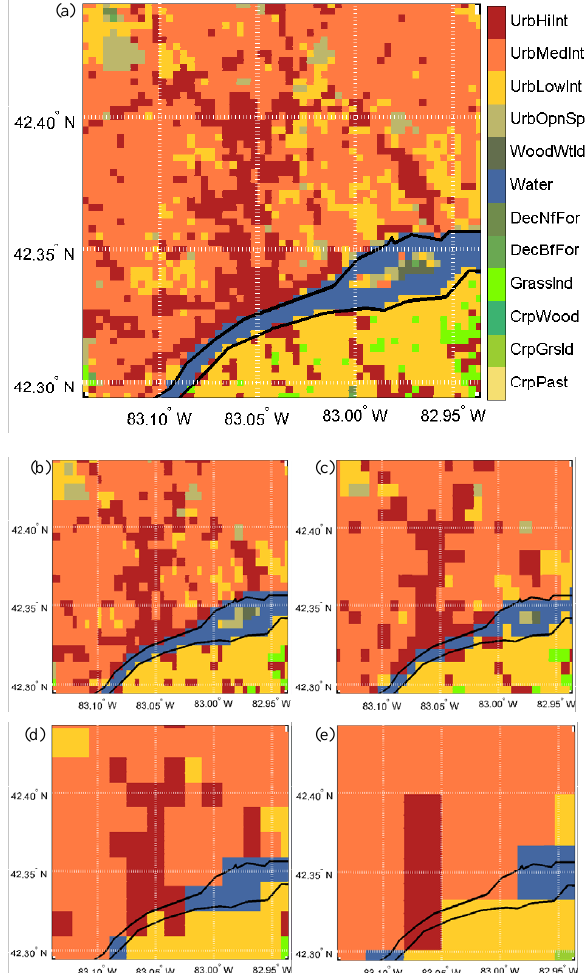
Fig. 7. Surface cover type over the fourth model grid of the Detroit- Windsor domain using 10s (a) , 20s (b) , 30s (c) , 60s (d) and 120s (e) surface cover resolution data. Color scheme in all sub- plots corresponds to that in (a) . See Appendix A for translation of abbreviations in